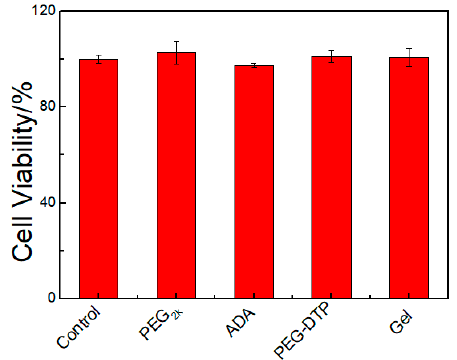
Figure 9. Cell (A549) viability upon exposure to PEG 2k , ADA, PEG-DPT, and hydrogel.